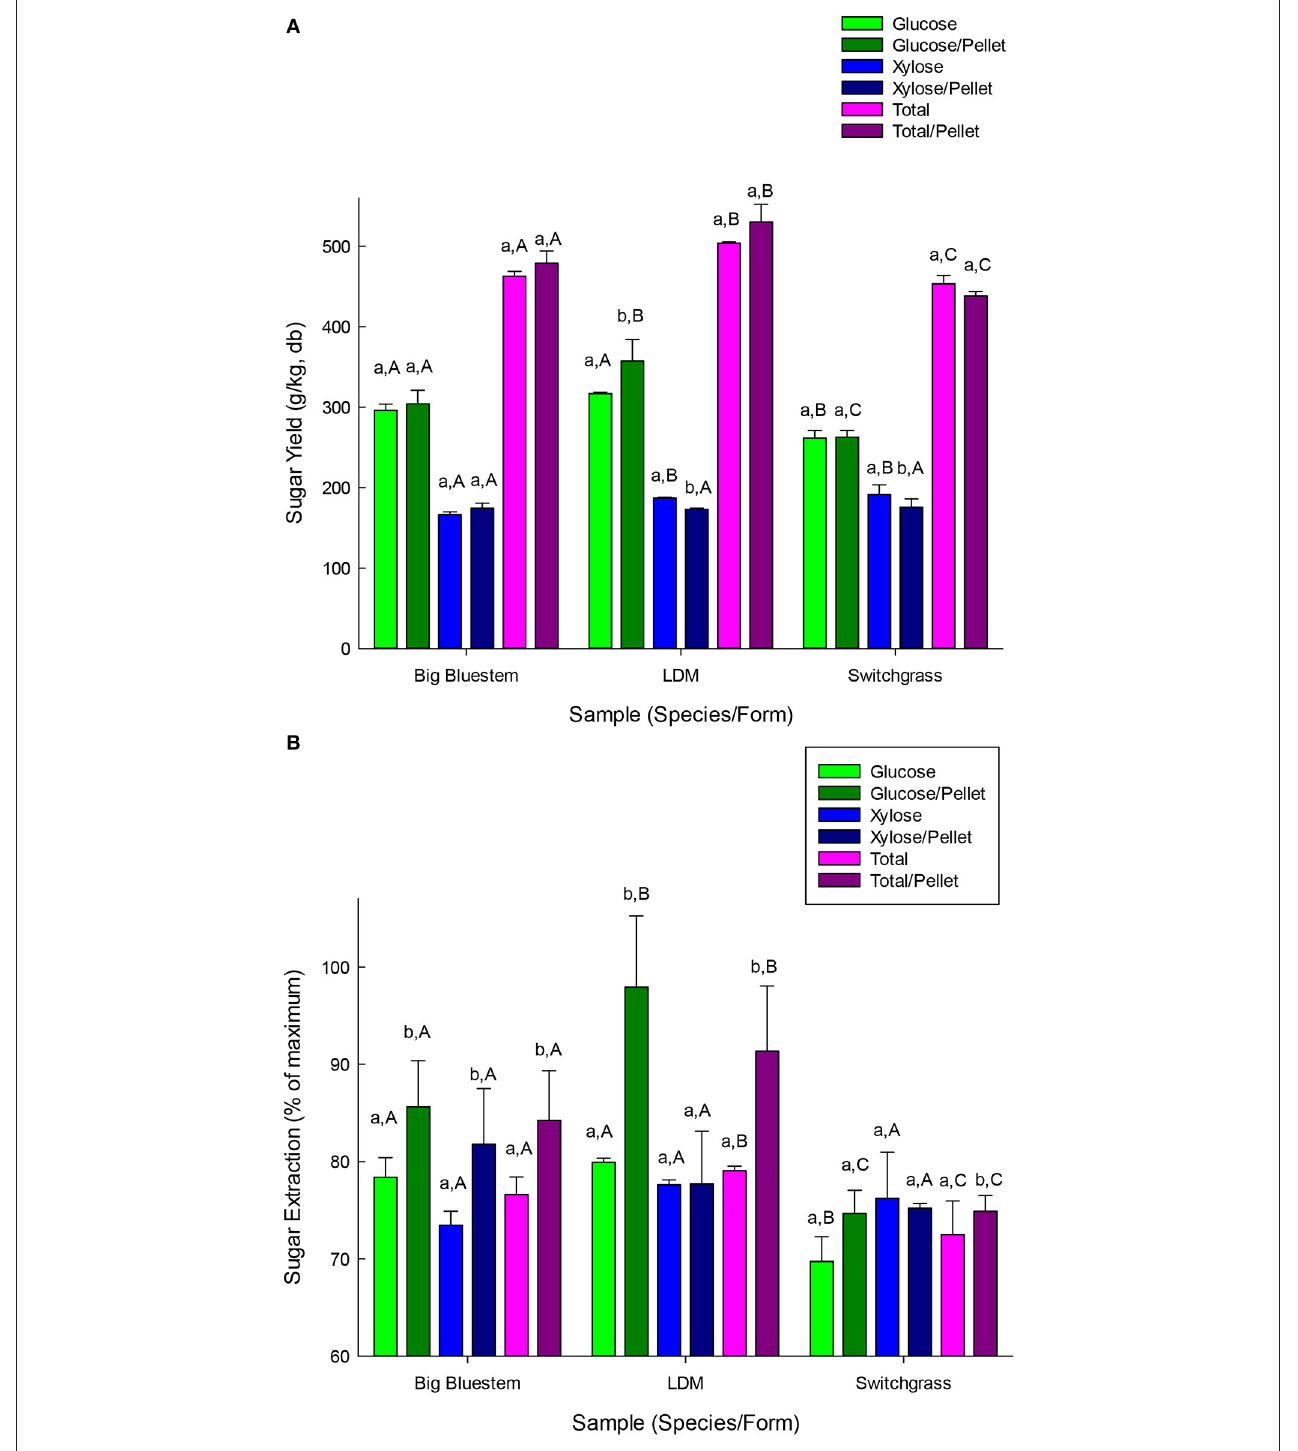
FIGURE 4 | (A) Yield of neutral sugars from pelletized and non-pelletized samples pretreated with liquid hot-water pretreatment followed by enzyme hydrolysis using commercial cellulases and hemicellulases. Results are mean of triplicate runs and error bars are standard deviations. Different lower-case letters represent significant differences based upon pellet vs. non-pellets and different capital letters represent significant differences based upon species for either pelleted or non-pelleted samples ( p < 0.05). (B) Sugar yield efficiencies (e.g., % sugars recovered) from pelletized and non-pelletized samples pretreated with liquid hot-water pretreatment followed by enzyme hydrolysis using commercial cellulases and hemicellulases. Results are mean of triplicate runs and error bars are standard deviations. Legend: reported on figure. Different lower-case letters represent significant differences based upon pellet vs. non-pellets and different capital letters represent significant differences based upon species for either pelleted or non-pelleted samples ( p < 0.05).